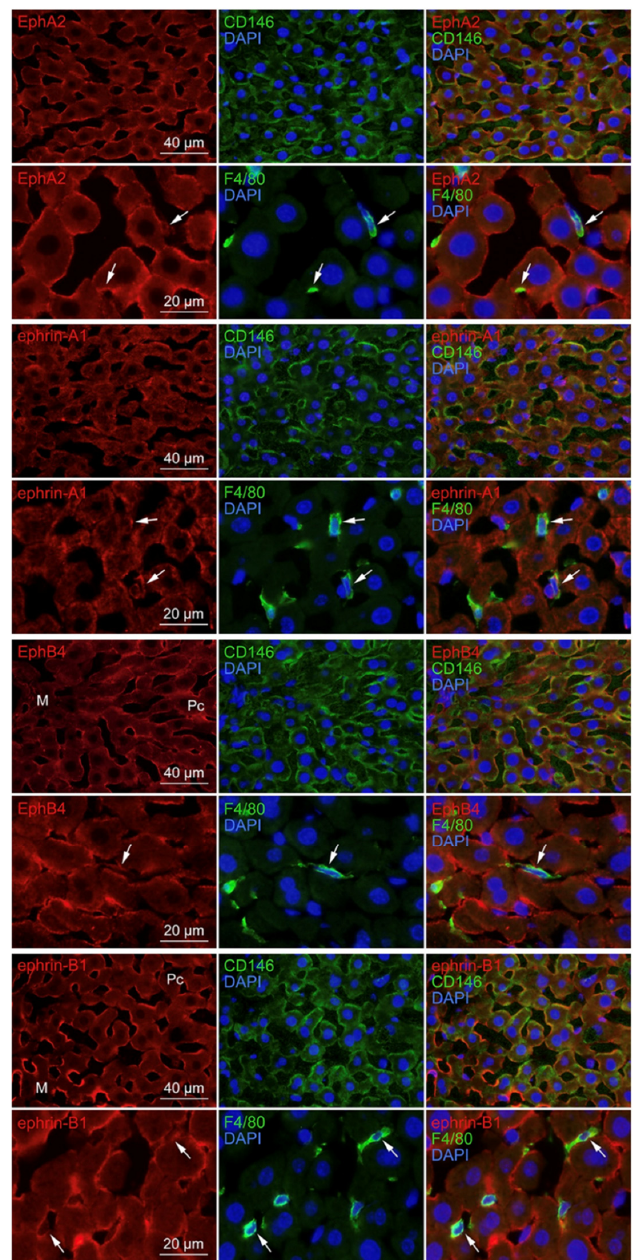
Figure 8. EphA2, ephrin-A1, EphB4, and ephrin-B1 localization in LSECs and Kupffer cells. Immunoflu- orescence micrographs showing EphA2, ephrin-A1, EphB4, and ephrin-B1 immunoreactivity (red) in CD146-positive LSECs (green) and F4/80-positive Kupffer cells (green) in the mouse liver. Cryostat sections were stained with the indicated antibodies and DAPI (blue). Green fluorescence images were merged with red, and/or blue fluorescence images in the same field. EphA2, ephrin-A1, EphB4, and ephrin-B1 immunoreactivity was localized in CD146-positive LSECs and weakly localized in F4/80-positive Kupffer cells (arrows). M, marginal region of the hepatic lobules; Pc, pericentral region of the hepatic